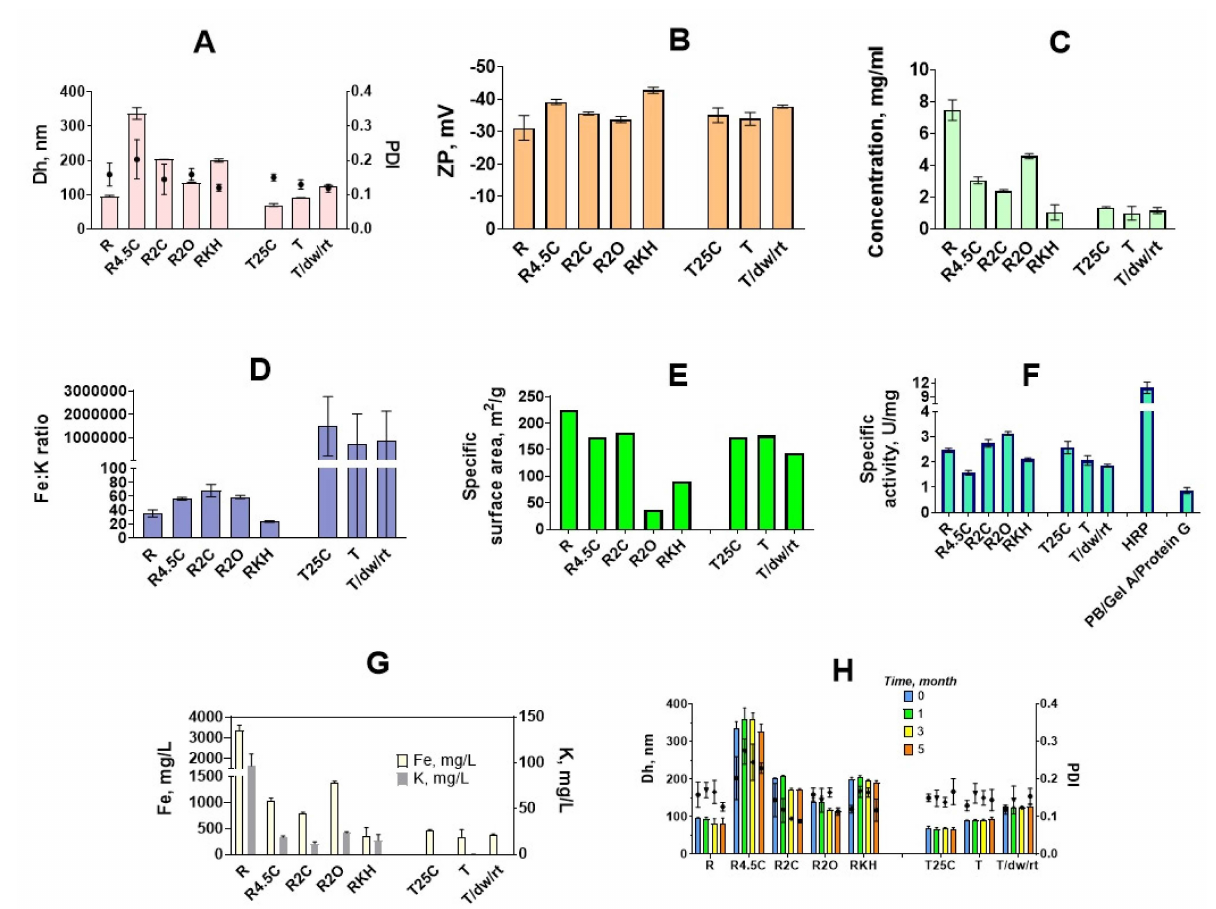
Figure 3. Characterization of prussian blue nanoparticles synthesized at 10x scale. ( A ) mean hy- drodynamic diameter (Dh; bars) and polydispersity index (PDI); ( B ) zeta potential (ZP) of obtained nanoparticles; ( C ) concentrations (dry mass per unit volume); ( D ) Fe:K mass ratio; ( E ) specific surface area; ( F ) peroxidase-like activity (HRP—horseradish peroxidase); ( G ) concentration of Fe (white bars) and K (gray bars); ( H ) size (Dh; bars) and polydispersity (PDI) of nanoparticles after 1, 3, and 5 months of storage at +4 ◦ C. n = 3, mean of three individual batches ± SD (for E, n =